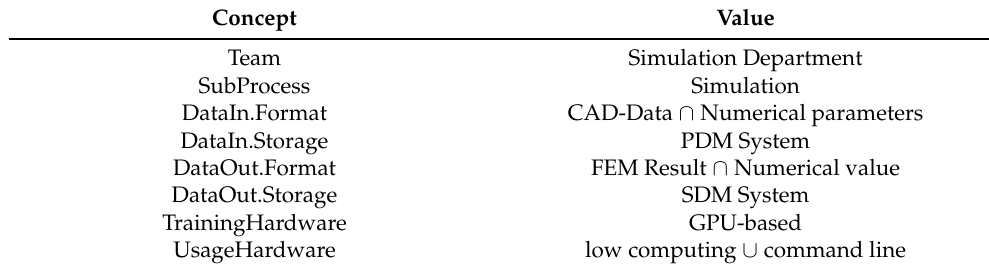
Table 2. Formal problem